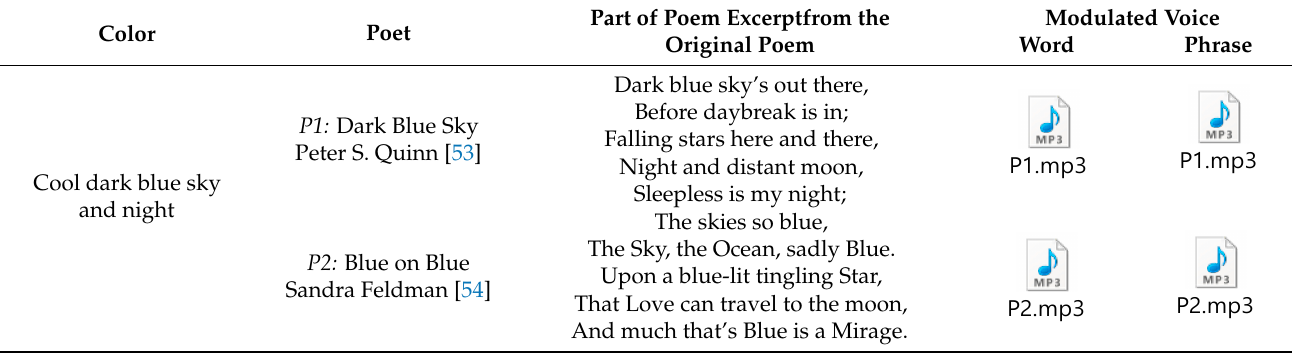
Table 6. Poetry for representing colors in Van Gogh’s “The starry night” (the sound files developed in this research are provided separately as a supplement material).